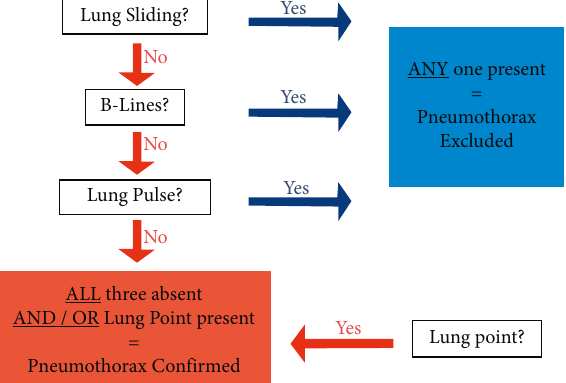
Figure 3: An algorithm for the diagnosis of pneumothorax using